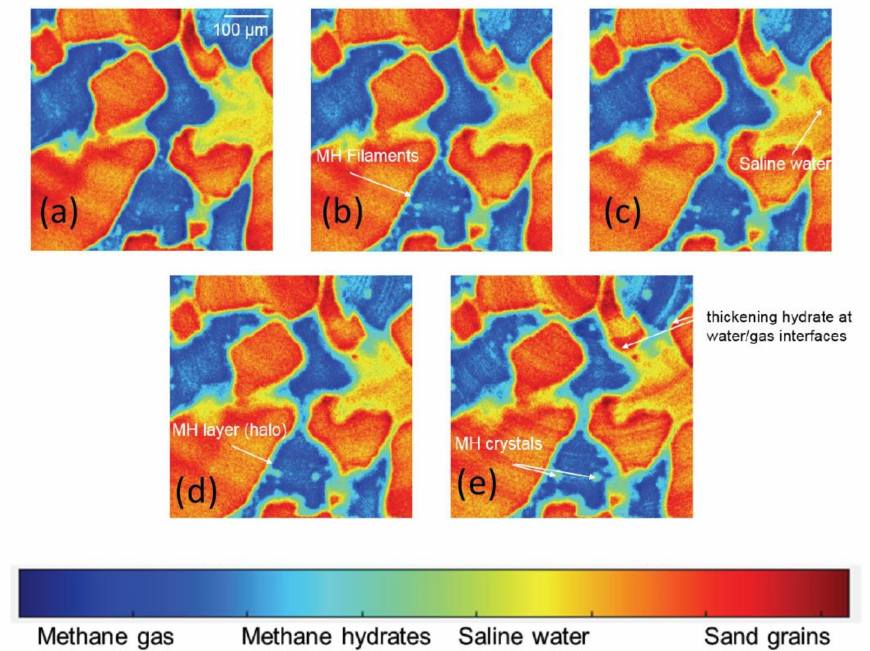
Figure 13. Tomographic sections of the growth of methane hydrate from brine in run 1: ( a ) 0.58 h; ( b ) 2 h; ( c ) 4 h; ( d ) 6 h; ( e ) 10